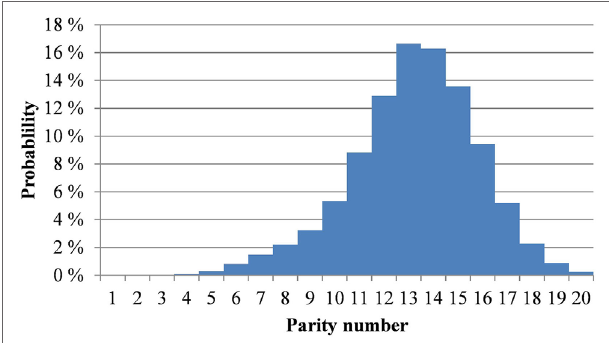
FigUre 3 | Probability distribution of litter size assumed in the dynamic programming model for primiparous sows.